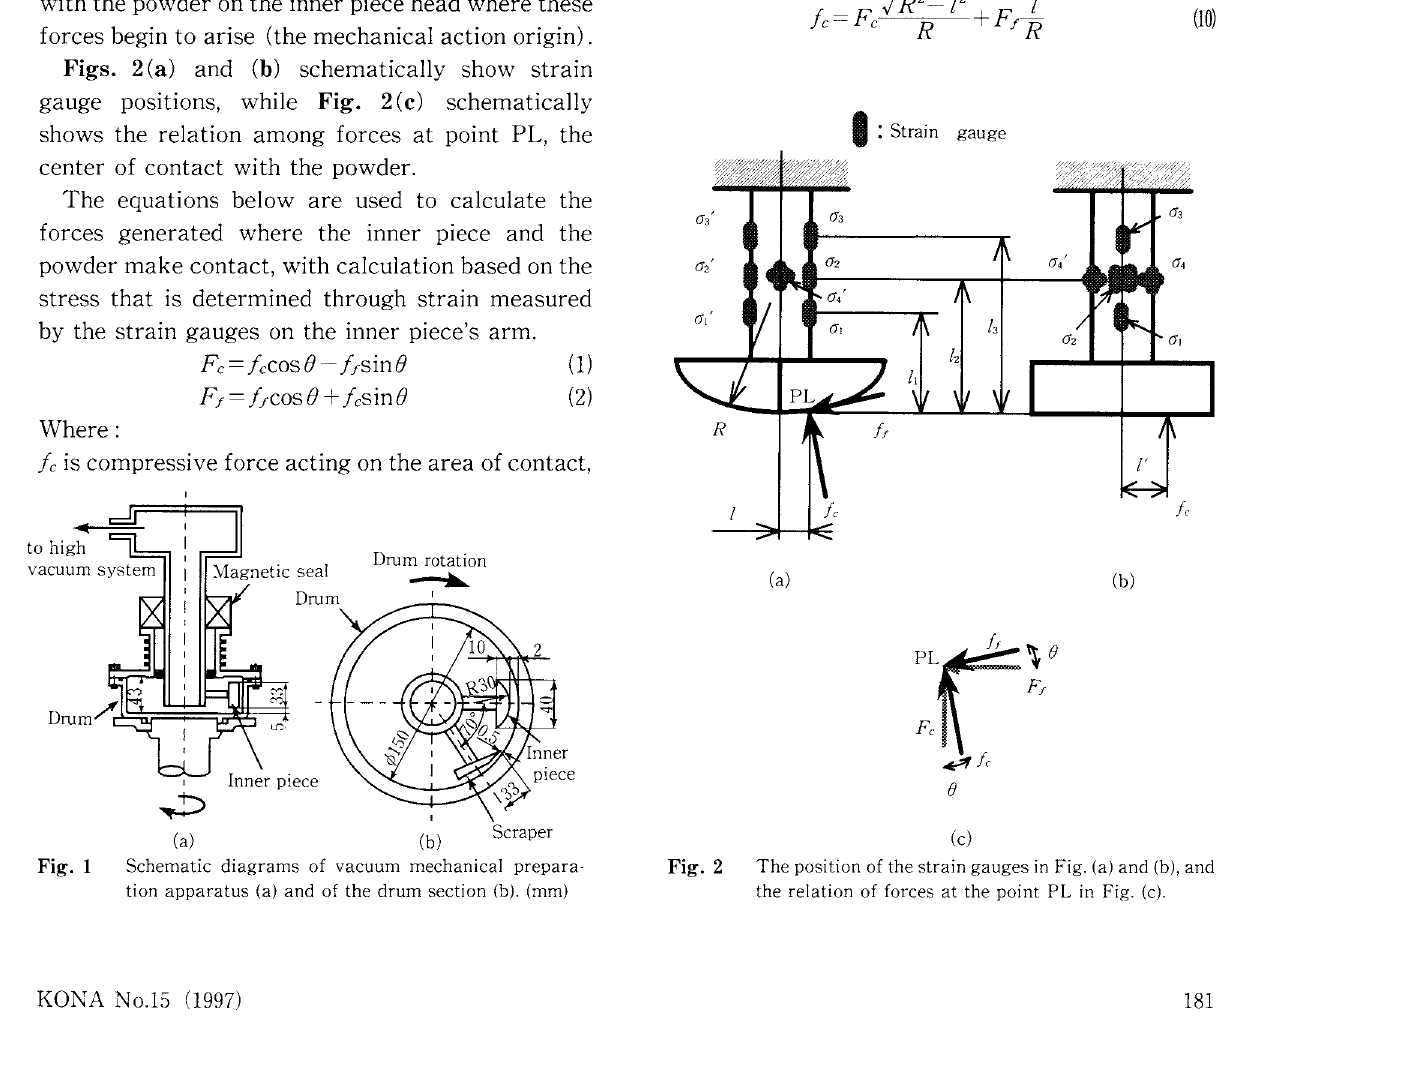
Schematic diagrams of vacuum mechanical prepara tion apparatus (a) and of the drum section (b). (mm)